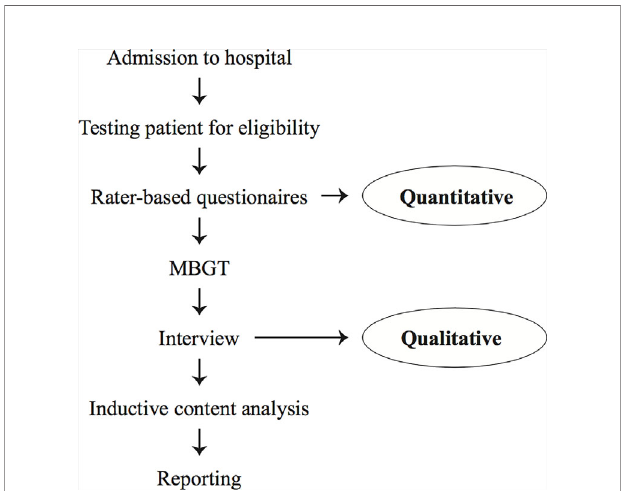
FIGURE 1 | Study fl ow